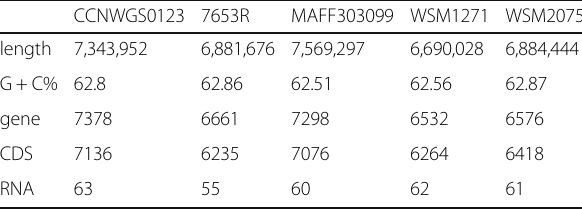
Table 6 General Information of five Mesorhizobium